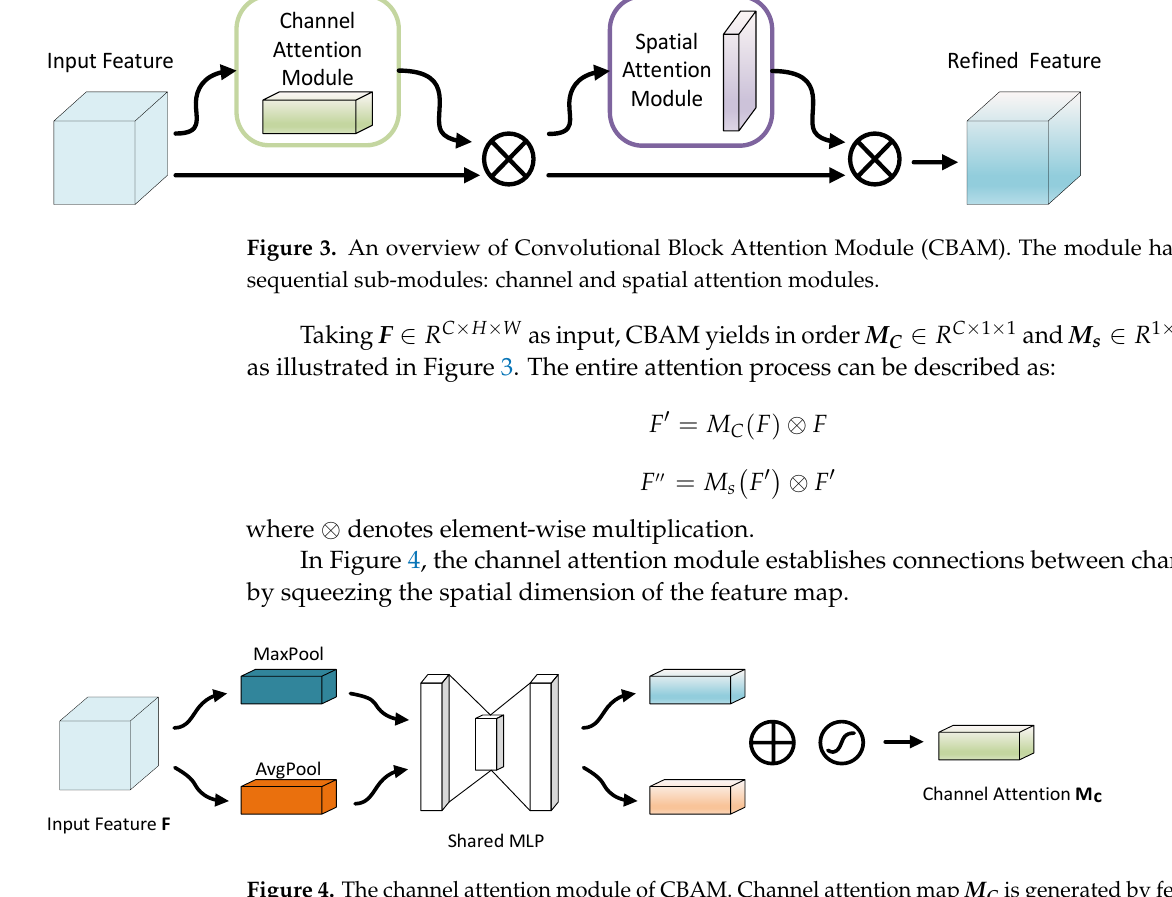
Figure 4. The channel attention module of CBAM. Channel attention map M C is generated by feeding the pooled feature maps into a shared network.